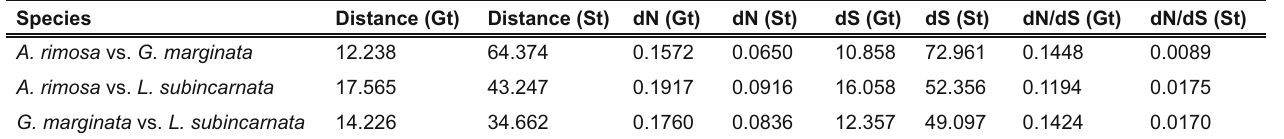
Table 4. (cid:2)V(cid:4)(cid:6)(cid:18)(cid:9)(cid:10)(cid:11)(cid:7)(cid:4)(cid:17)(cid:2)(cid:4)(cid:26)(cid:2)(cid:21)(cid:11)(cid:7)(cid:8)(cid:9)(cid:17)(cid:19)(cid:13)(cid:7)(cid:2)(cid:9)(cid:17)(cid:21)(cid:2)(cid:7)(cid:5)(cid:12)(cid:7)(cid:8)(cid:11)(cid:8)(cid:5)(cid:8)(cid:11)(cid:4)(cid:17)(cid:2)(cid:10)(cid:9)(cid:8)(cid:13)(cid:7)(cid:2)(cid:4)(cid:26)(cid:2)(cid:25)(cid:13)(cid:17)(cid:13)(cid:2)(cid:9)(cid:17)(cid:21)(cid:2)(cid:7)(cid:18)(cid:13)(cid:19)(cid:11)(cid:13)(cid:7)(cid:2)(cid:8)(cid:10)(cid:13)(cid:13)(cid:7)(cid:2)(cid:9)(cid:6)(cid:4)(cid:17)(cid:25)(cid:2)(cid:8)(cid:14)(cid:13)(cid:2)(cid:8)(cid:14)(cid:10)(cid:13)(cid:13)(cid:2)(cid:9)(cid:6)(cid:9)(cid:17)(cid:11)(cid:8)(cid:11)(cid:17)#(cid:18)(cid:10)(cid:4)(cid:21)(cid:5)(cid:19)(cid:11)(cid:17)(cid:25)(cid:2)(cid:25)(cid:13)(cid:17)(cid:13)(cid:10)(cid:9)(cid:28)